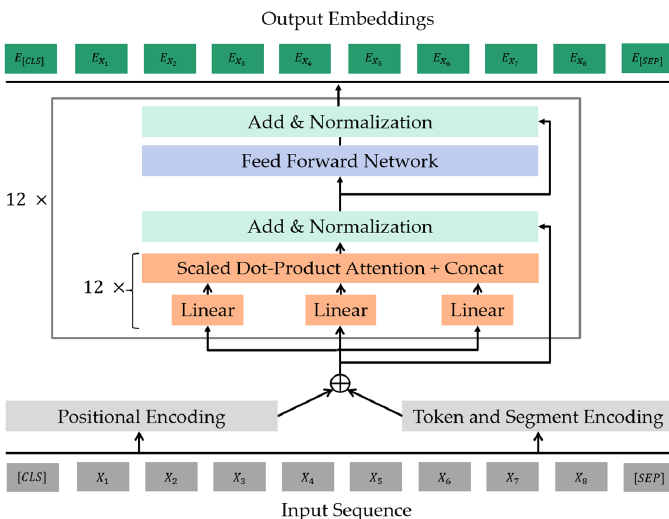
Figure 10. The framework of the embedding